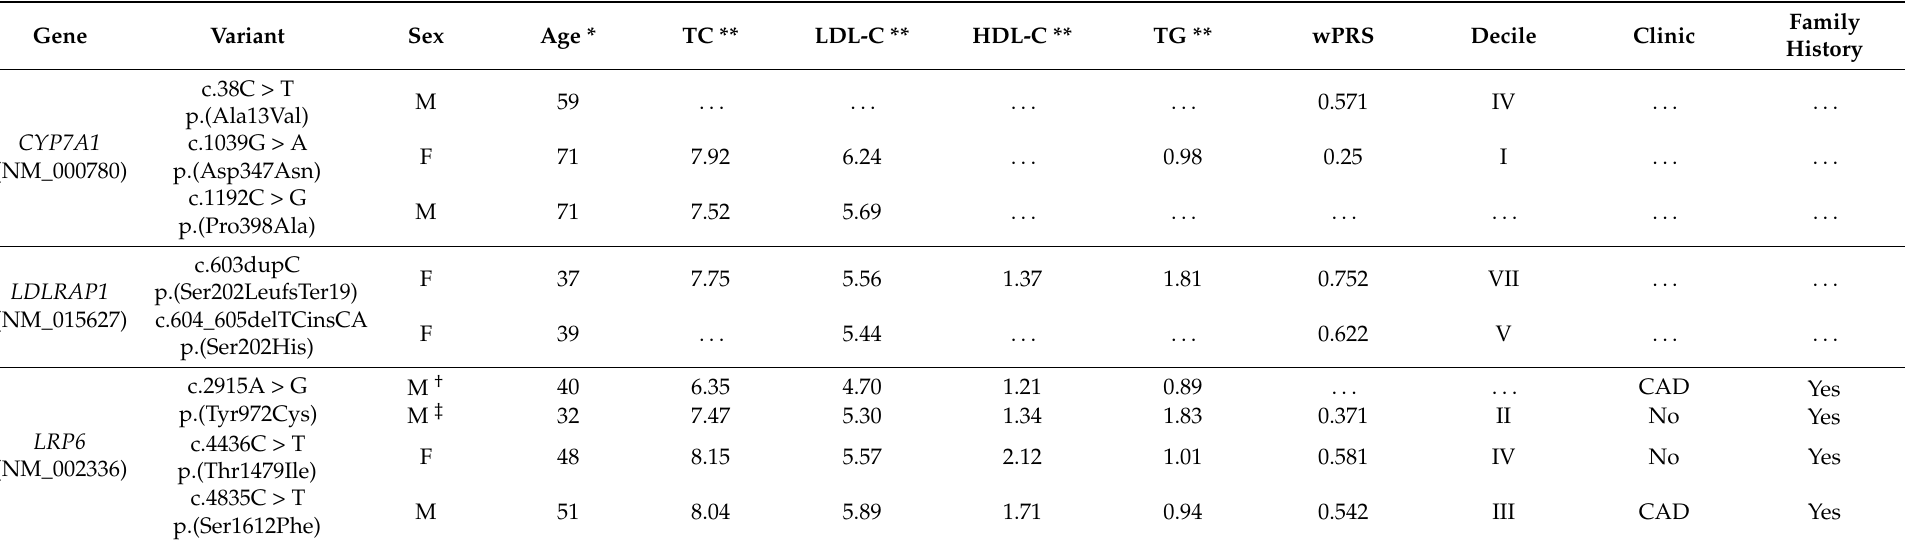
Table 2. Biological and clinical characteristics of the affected carriers of CYP7A1, LDLRAP1 and LRP6